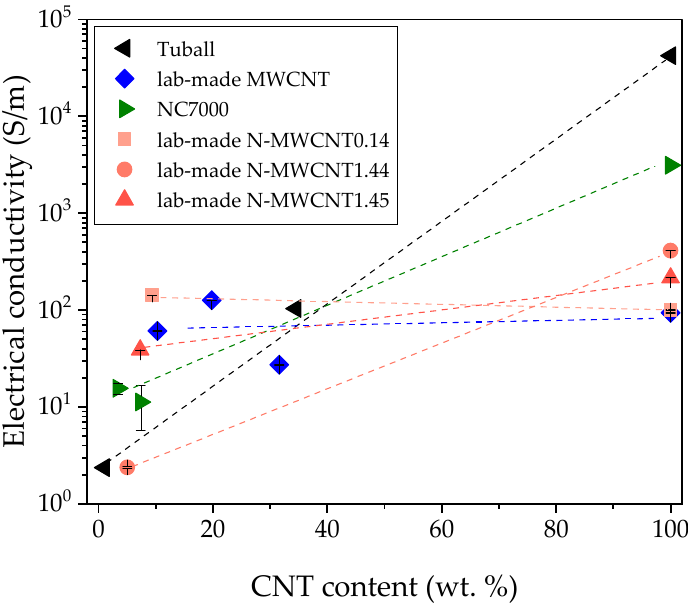
Figure 10. Electrical conductivity of CNT buckypapers and epoxy composites in dependence on the CNT content sorted by color: lab-made MWCNT ( blue ), commercial MWCNTs ( green ), lab-made N-MWCNTs ( red ), commercial SWCNT ( black ).